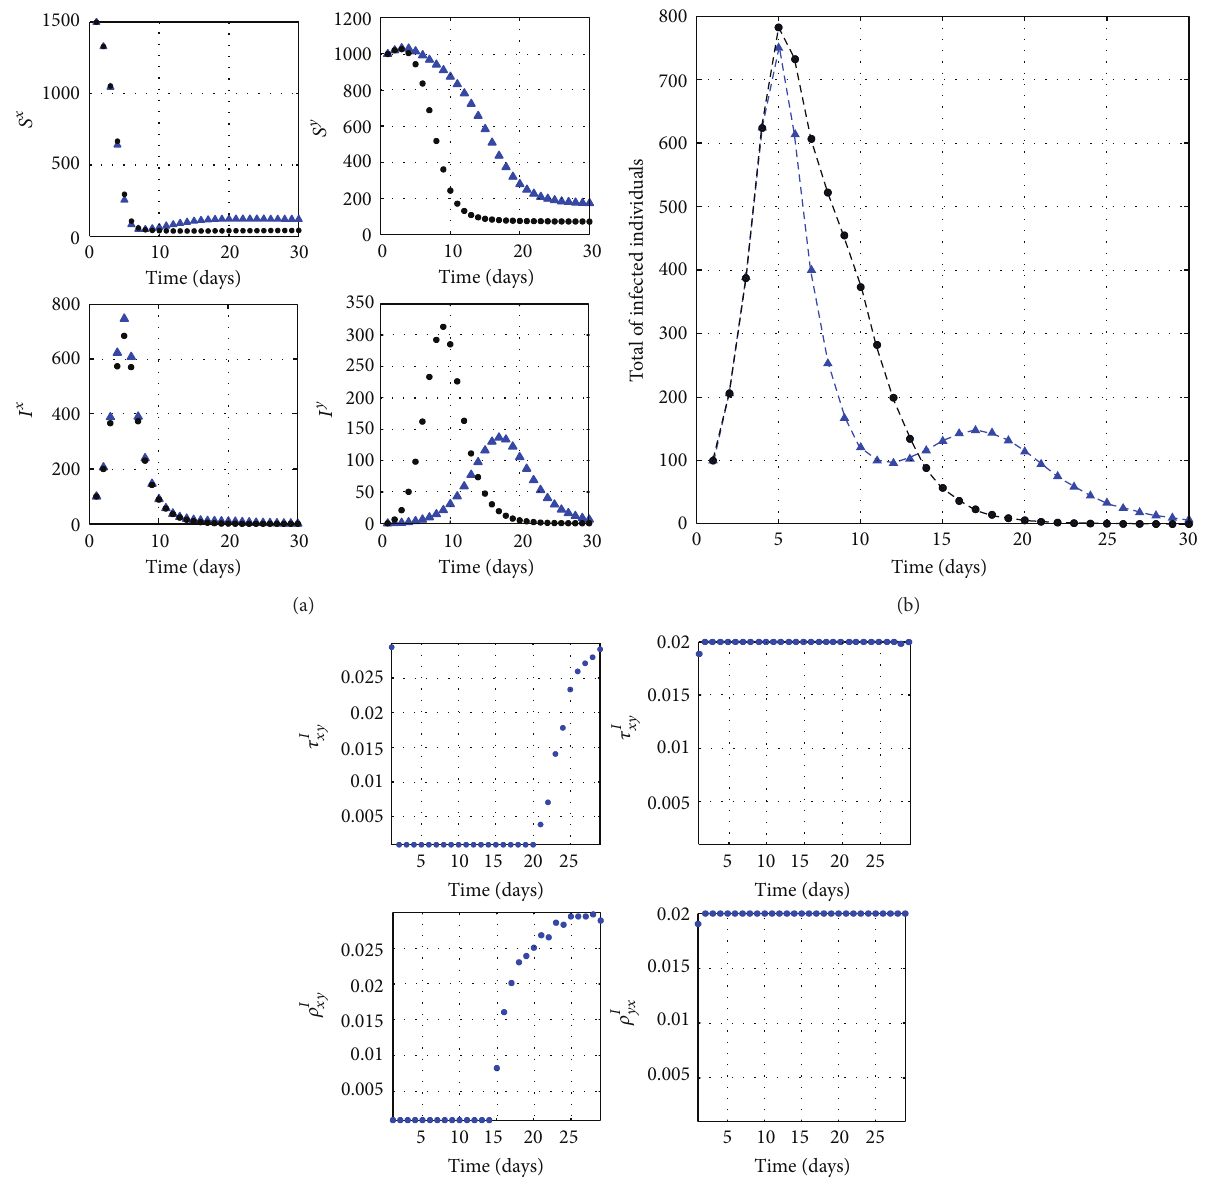
Figure 2: (a) The evolution of the worst case scenario, that is, when no control is applied, is shown in bullets ( ∙ ) for susceptibles and infected classes in each patch. Using the parameter values found by the algorithm provides the scenario shown in ( 󳵳 ). (b) The total amount of infected individuals in both populations. Again, the worst case scenario is in ( ∙ ) and the minimized results in ( 󳵳 ). The appearance of a second bump is due to the delay of introducing infective individuals in the initially disease-free population. (c) These are the strategy levels that minimize the total